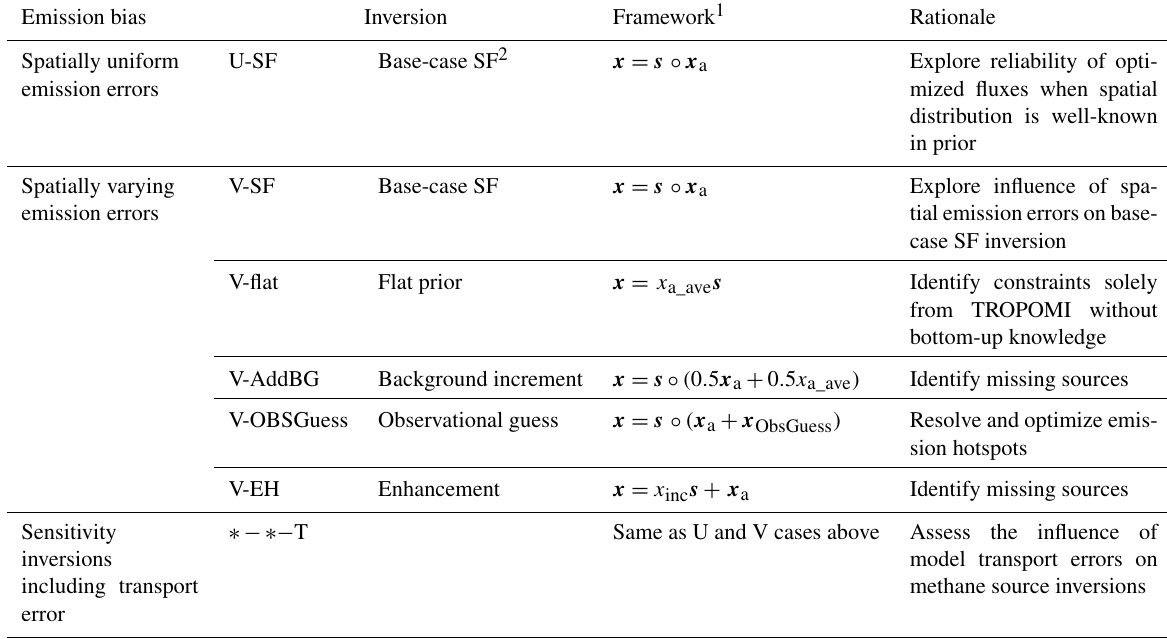
Table 1. Inversion